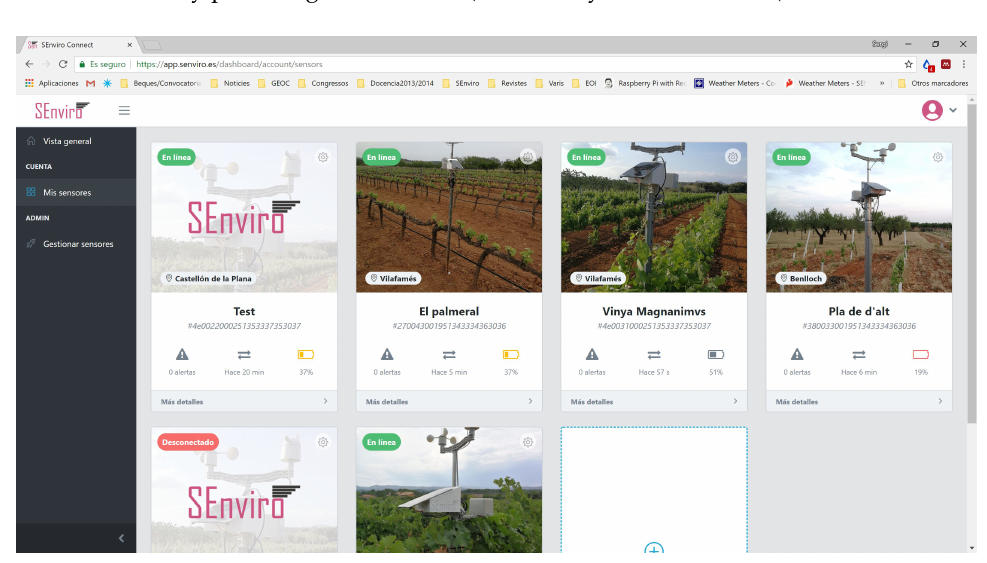
Figure 14. A screenshot of the SEnviro connect showing the node management view.